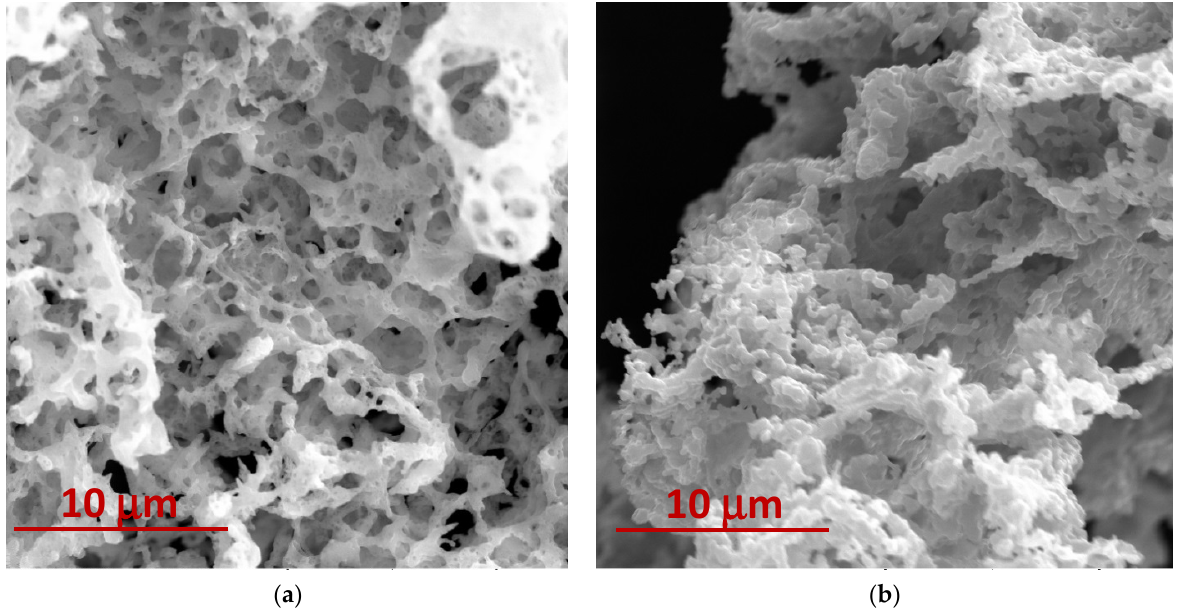
Figure 5. SEM images of NiMn 2 O 4 powder after combustion ( a ) and calcination ( b ).